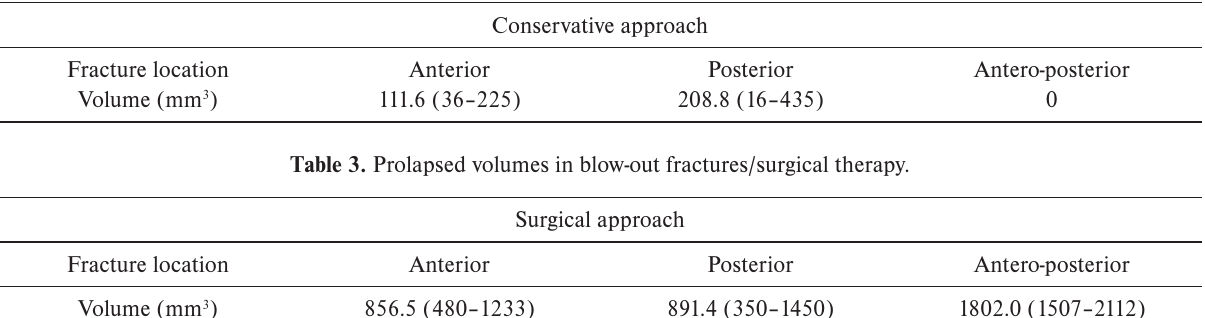
Table 2. Prolapsed volumes in blow-out fractures/conservative therapy.